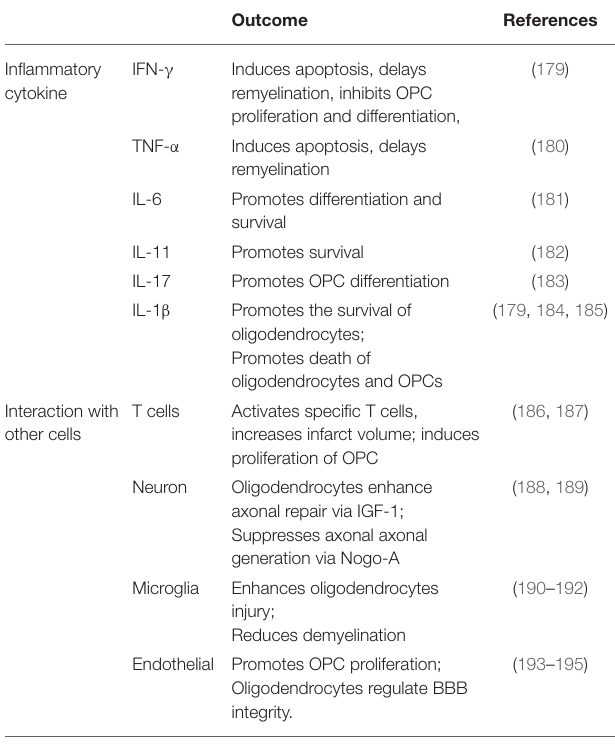
TABLE 2 | Oligodendrocytes and oligodendrocyte progenitor cells in post-stroke neuroinflammation.